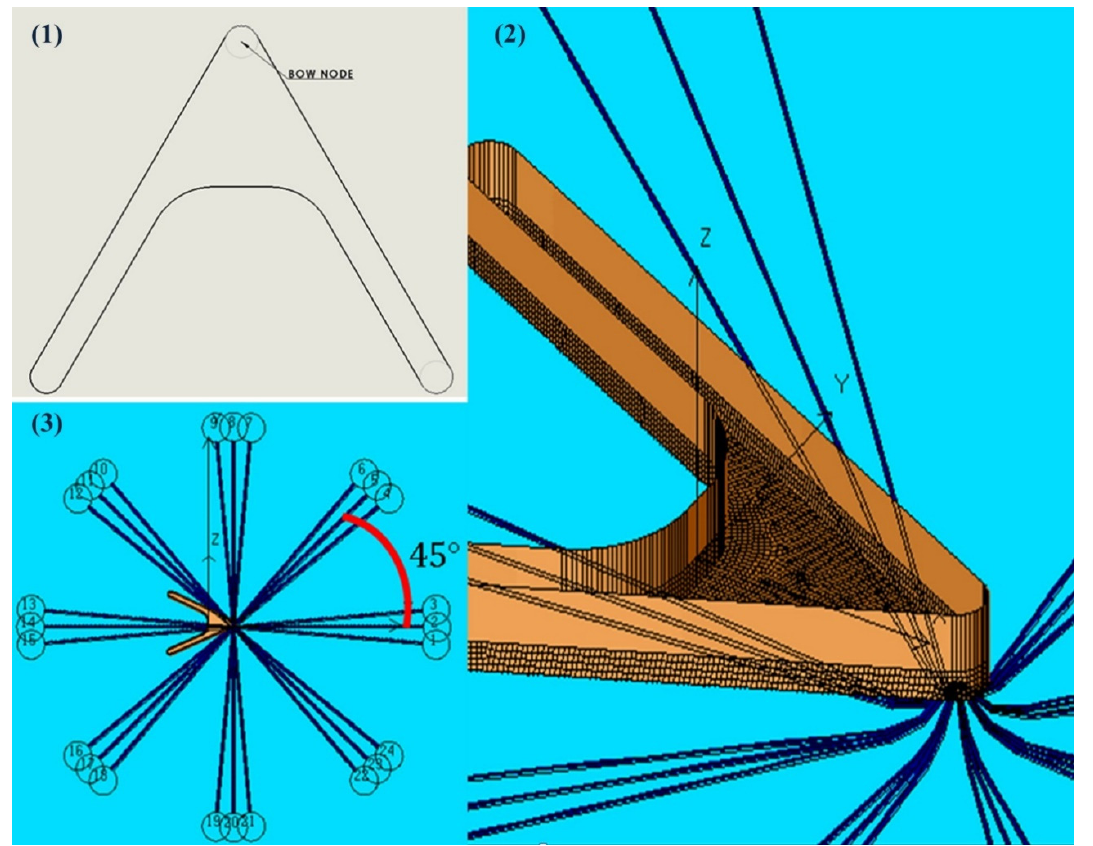
Figure 4. Mooring configuration setup. ( 1 ) Bow node location, upper view; ( 2 ) connection point; ( 3 ) mooring lines arrangement. Note: actual geometric configuration and dimensions of the Delta are as shown in Figure 3. Table 4. Specification of the Delta’s SPM mooring lines.